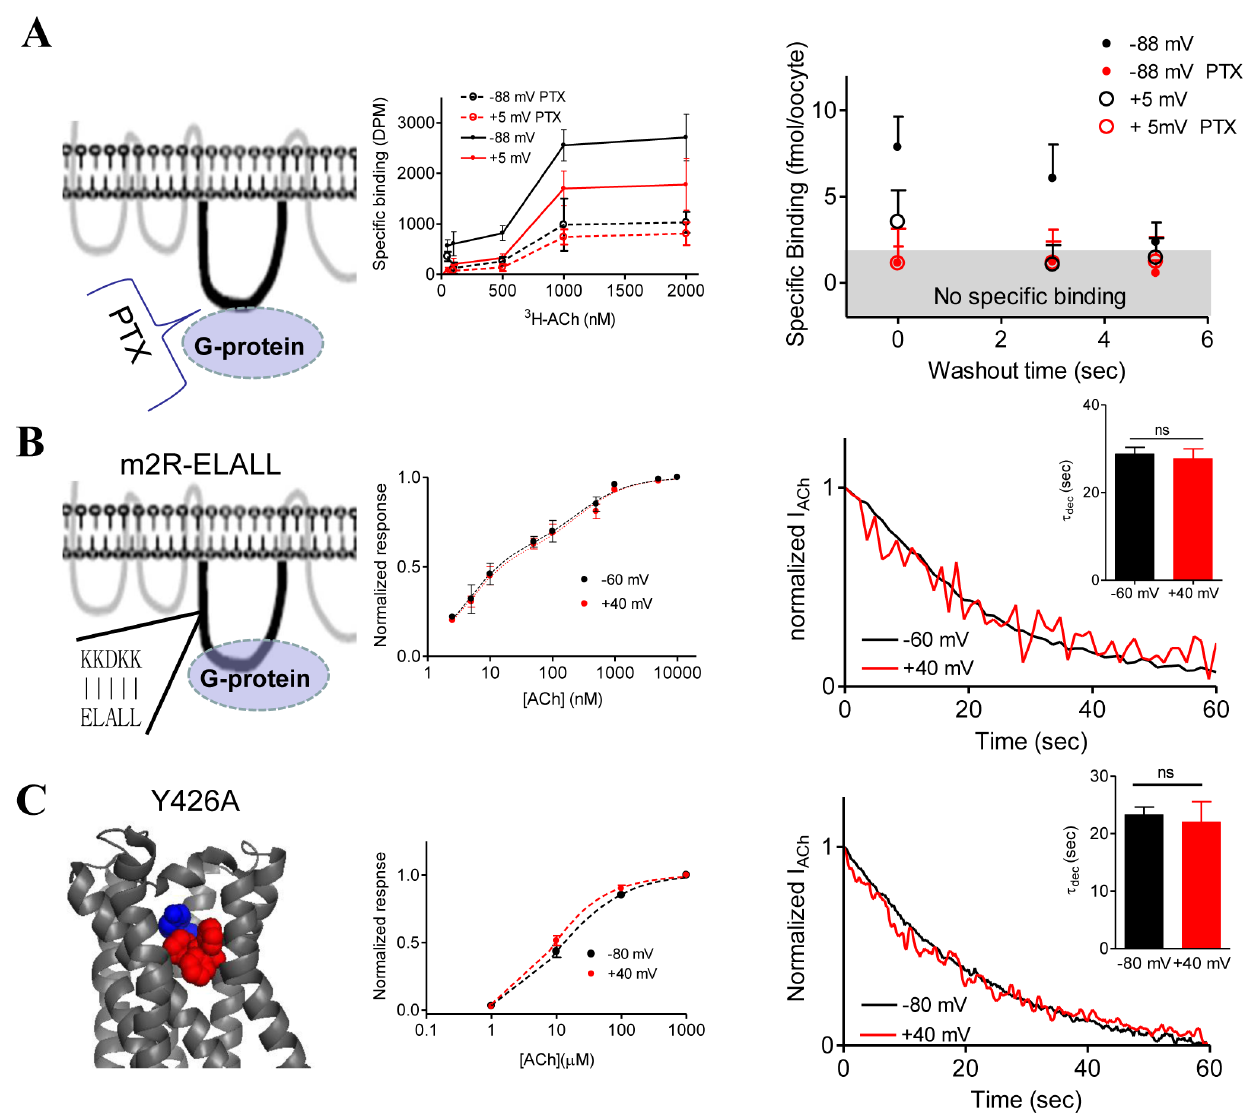
Figure 5. The mechanism of voltage dependent shift in k off . (A) Effect of PTX treatment on dissociation of [ 3 H]ACh from m2R-expressed oocytes. Left , PTX uncouples the G-protein from the GPCR. This causes reduction of the binding affinity and abolishment of the voltage sensitivity of the affinity and abolish the voltage sensitivity of the binding ( Middle , taken with permission from [7]). Right , Dissociation of [ 3 H]ACh from m2R- expressed oocytes after different washout times, at two membrane potentials, with and without PTX treatment. The data is average 6 SEM of 10 and 12 oocytes. The specific binding after PTX treatment was not significant for all data points. As seen, after PTX treatment the voltage dependence of t dis was abolished. (B) t dec is voltage insensitive in m2R- ELALL expressed oocytes. Replacement of 5 residues in the N-terminal of L 3 ( Left) abolished the voltage sensitivity of the binding affinity ( Middle ,taken with permission from [6]) Right , Measurements of t dec at 2 60 mV and + 40 mV from the same oocyte. Inset . Collected data from 17 ( 2 60 mV) and 23 ( + 40 mV) oocytes. The bars are not significantly different; p =0.74. (C) t dec is voltage insensitive in m2R-Y426A expressed oocytes. Left , Side view representation of the m2R based on [36] highlighting residue Y426 (red) in the ligand binding site. A ligand bound to the binding site is shown as a blue sphere. Middle , Dose-Response relation of the Y426A mutant exhibits low affinity and lack of voltage sensitivity. Taken with permission from [8]. Right , t dec at 2 80 mV and + 40 mV measured from the same oocyte. Inset , Collected data obtained with m2R-Y426A expressed oocytes. Each bar represents the mean 6 SEM of 11 ( 2 80 mV) and 6 ( + 40 mV) oocytes. The bars are not significantly different ( p